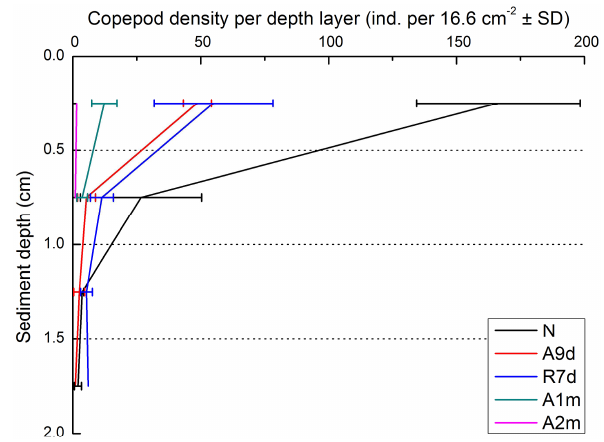
Fig. 5. Average ( ± SD) copepod density (ind. per 16.6cm − 2 ) in four sediment layers (0–0.5, 0.5–1, 1–1.5 and 1.5–2cm) and in different treatments; N = normoxia, A = anoxia, R = recovery; duration of treatment: 7days, 9days, 1month, 2months. to low oxygen concentrations (see review by Wetzel et